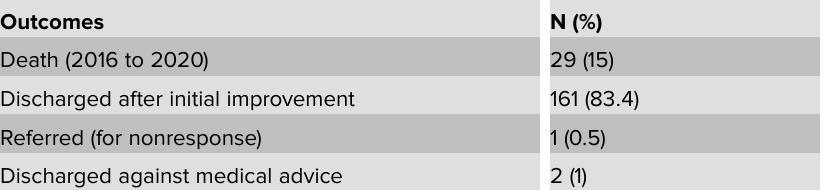
Table 6: Early outcomes for VL patients who were admitted to the